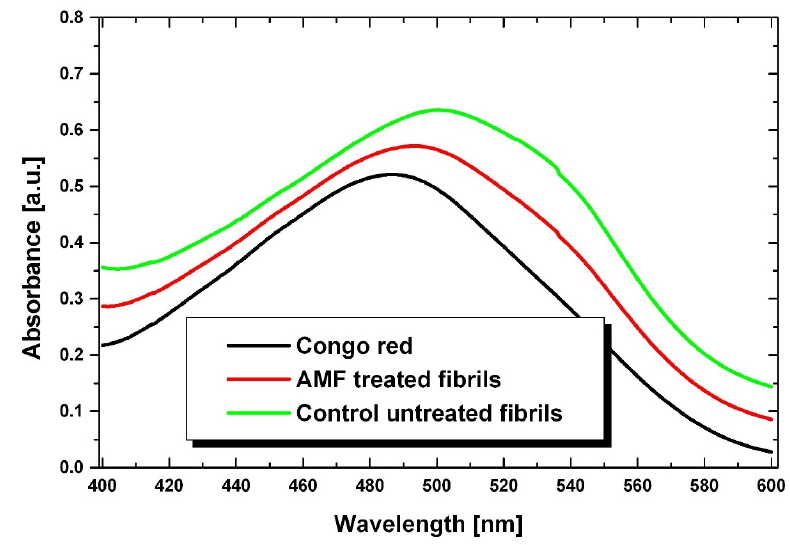
Figure 7. Absorbance of fibrils stained with Congo red. AMF-treated fibrils corresponding to the presence of 0.9 mg/mL of magnetic nanoparticles.